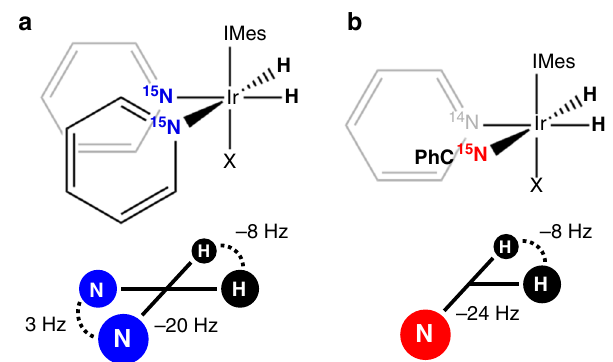
Fig. 1 Model SABRE systems. a DARTH-SABRE (4-spin AA ’ XX ’ system) and b coherent SHEATH (3-spin AA ’ X system) experiment. The magnetic structure of each system is shown below the chemical structure along with its homonuclear (dashed) and heteronuclear